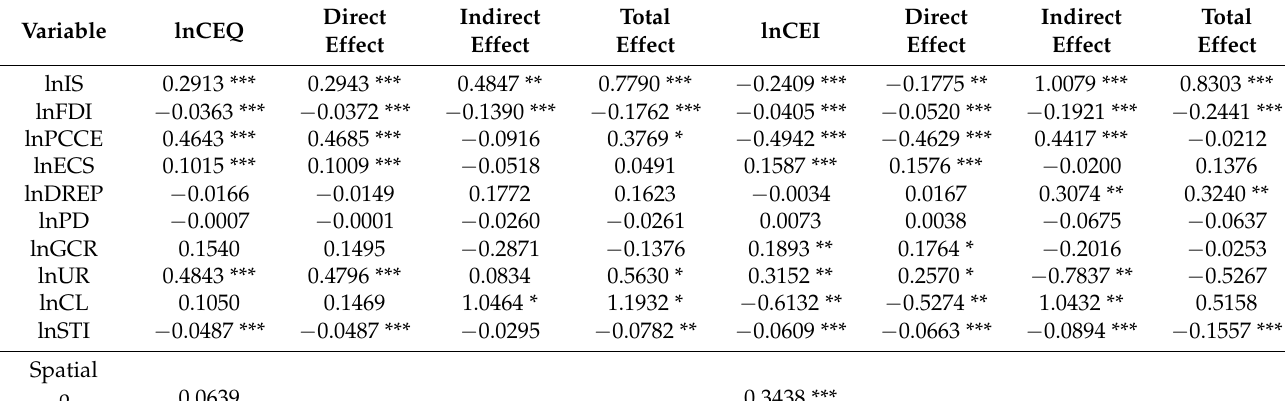
Table 14. Robustness test results of carbon emission quantity and carbon emission